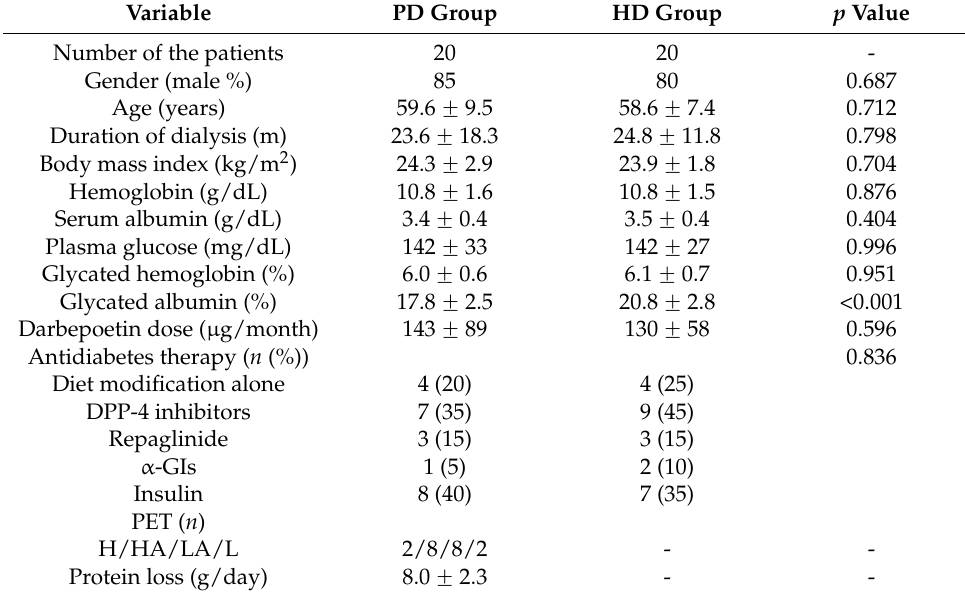
Table 1. Comparison of diabetic patients based on type of dialysis